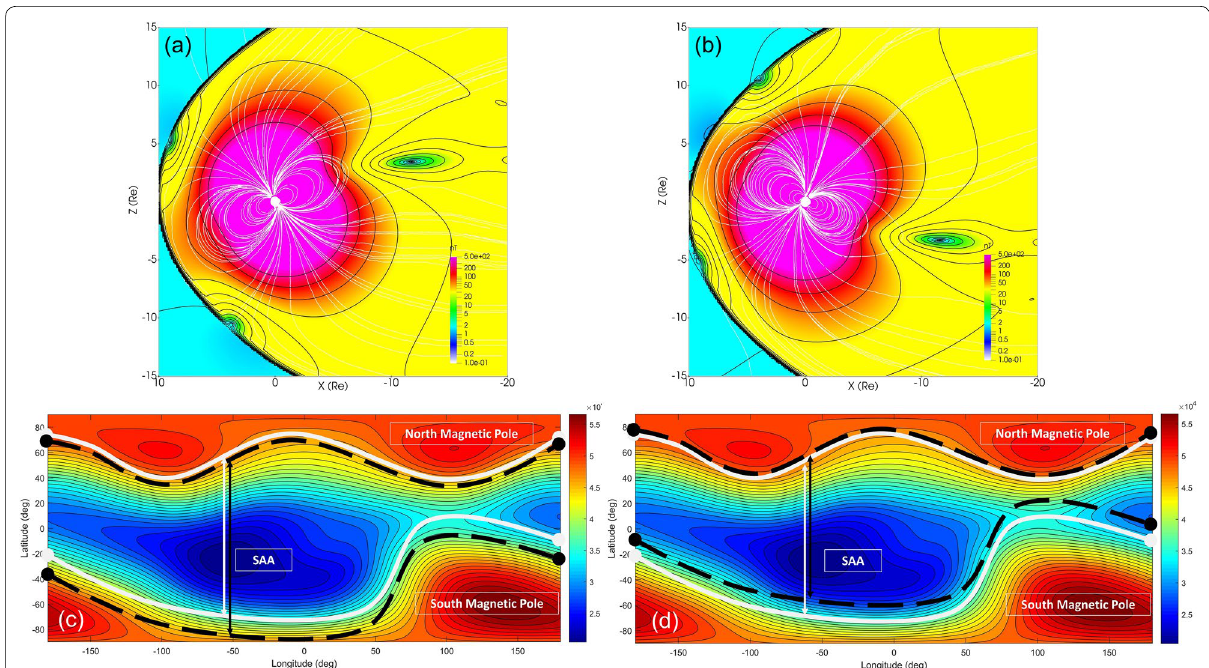
Fig. 8 Geodipole tilting effect. The figure shows the effects of the geodipole tilting angle on the magnetic poles and the SAA. a , b show the contour plots of the magnetic strength (black lines) and the field lines (white lines) for the two geodipole tilting angles, 29.5° and respectively. c , d correspond to the contour mapping of the magnetic strength, according to a , b , respectively, where the white lines represent the initial position of the magnetic pole boundaries and the dotted black lines, constitute the variations of the magnetic pole boundaries. The contour lines and the colors are plotted according to the logarithmic